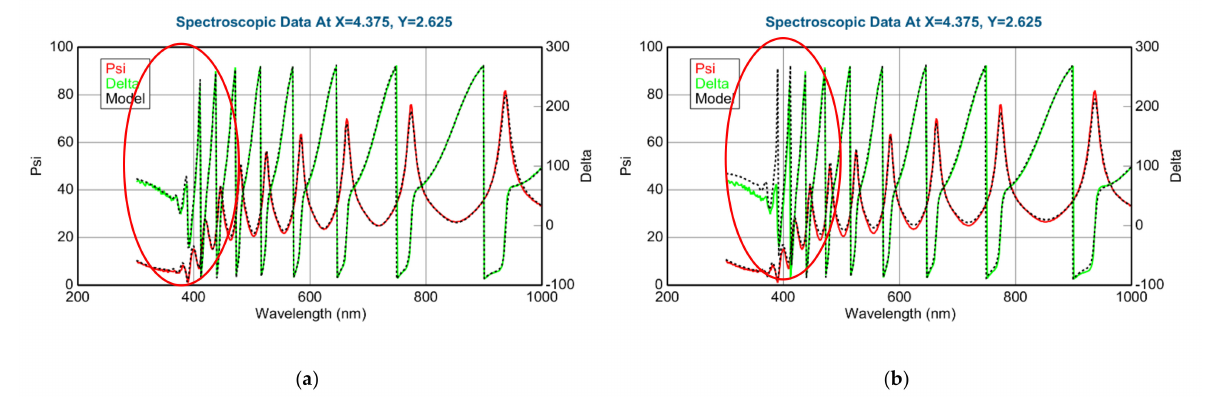
Figure 15. Measured and fitted spectra at one sample point: 2-Tauc-Lorentz (2-T-L) oscillator model. ( a ) Fit error (MSE) = 30.4, Thickness = 1159.6 ± 2.9 nm, Amp1 = 39.2 ± 1.1, Amp2 = 26.7 ± 0.4), and Effective Medium Approximation model; ( b ) fit error (MSE) = 40.1, Thickness = 1081.7 ± 2.8 nm, EMA% (Mat2) = 41.8 ± 0.8).